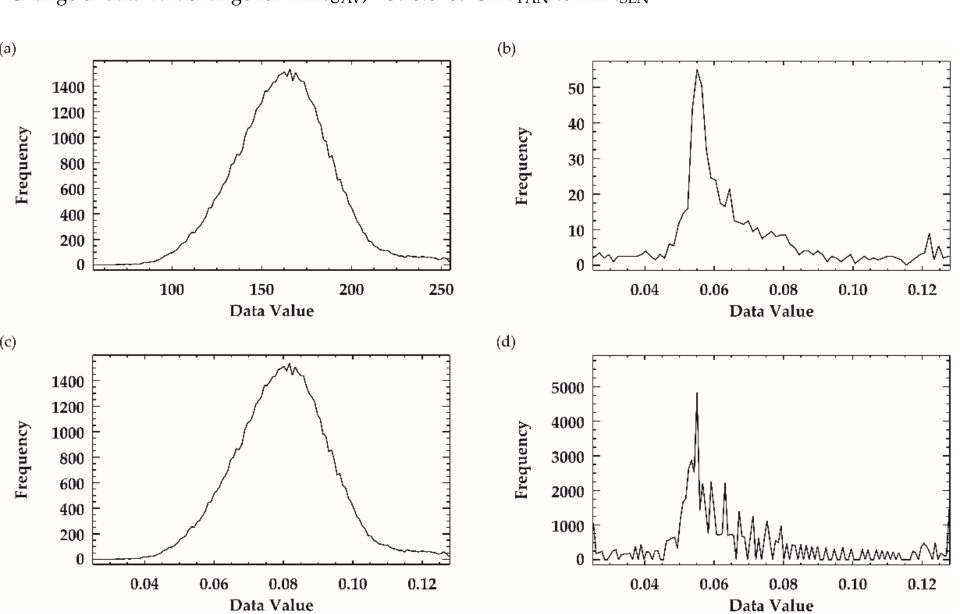
Figure 8. Stages of stretching the UAV panchromatic band (PAN UAV ) histogram: ( a ) PAN UAV histogram obtained after computing the panchromatic band; ( b ) PAN SEN histogram obtained after computing the panchromatic band ( c ) changing the data range for PAN UAV to make the range match that of PAN SEN ; ( d ) stretching the histogram from PAN UAV to PAN SEN and matching them. The colour-infrared (CIR) composition indicated the vegetation occurrence with